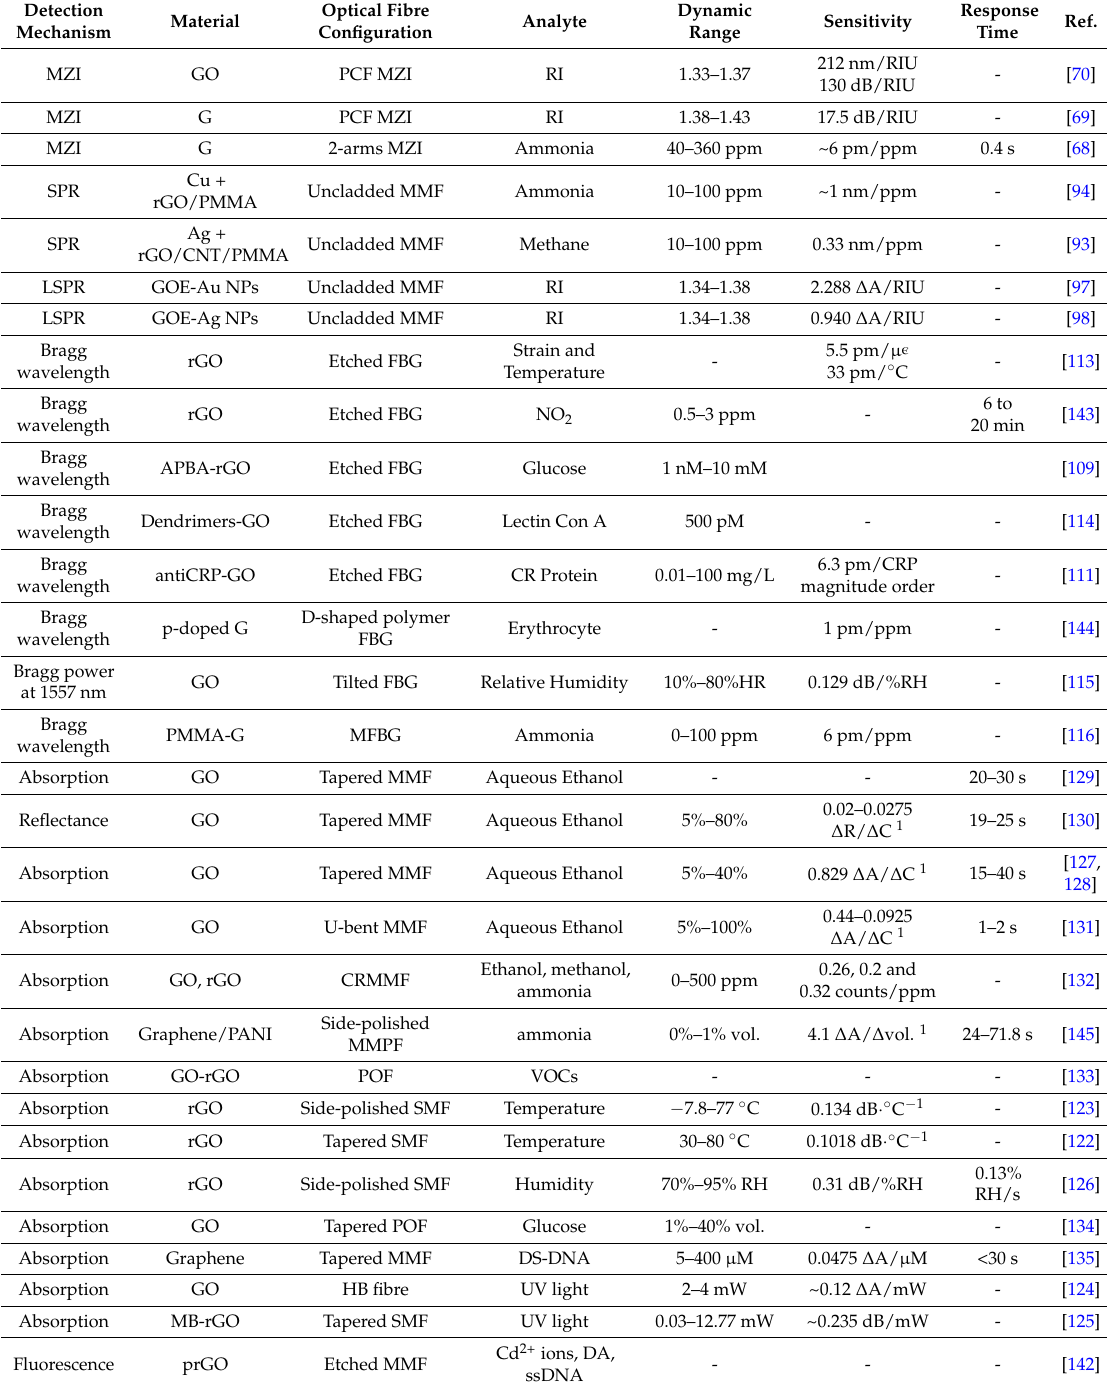
Table 1. Summary of graphene-based optical fibre sensors.